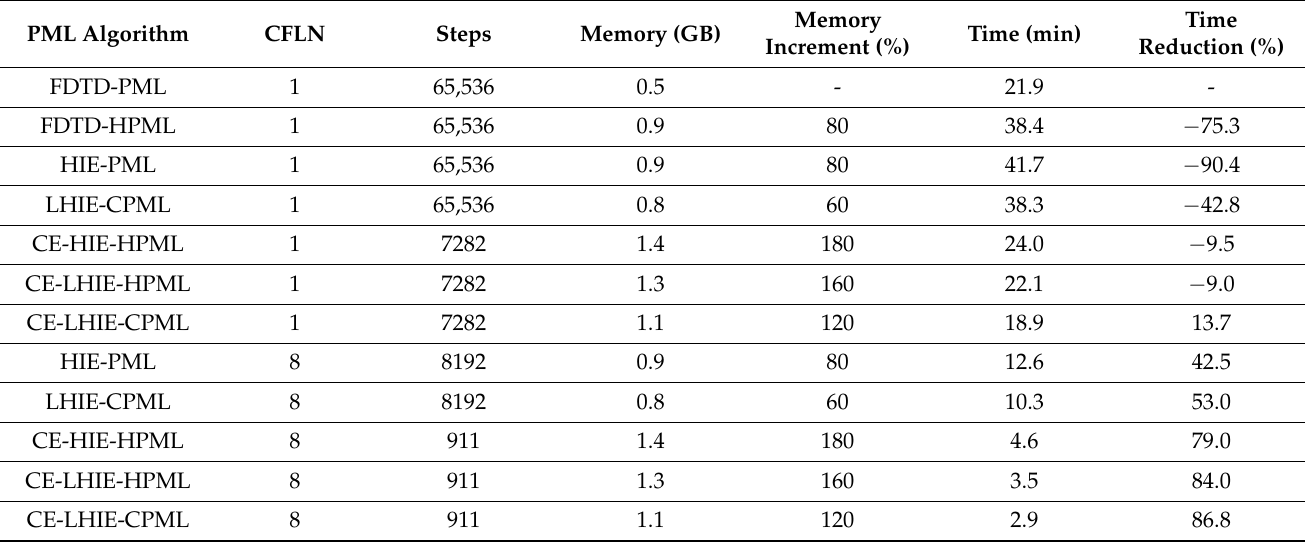
Table 3. The computational duration, consumption memory, iteration step, memory increment and time reduction obtained by different PML algorithms.